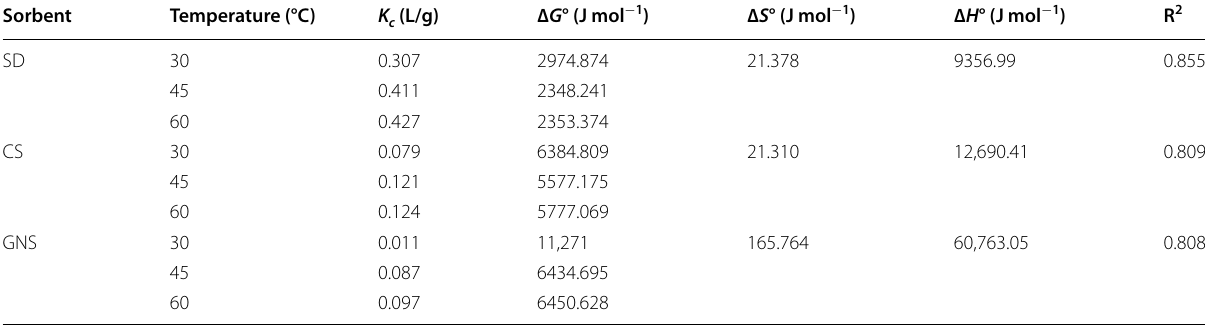
Table 5 Values of thermodynamic parameters and equilibrium constants for sorption of MB onto SD, CS and GNS at 30 °C, 45 °C and 60